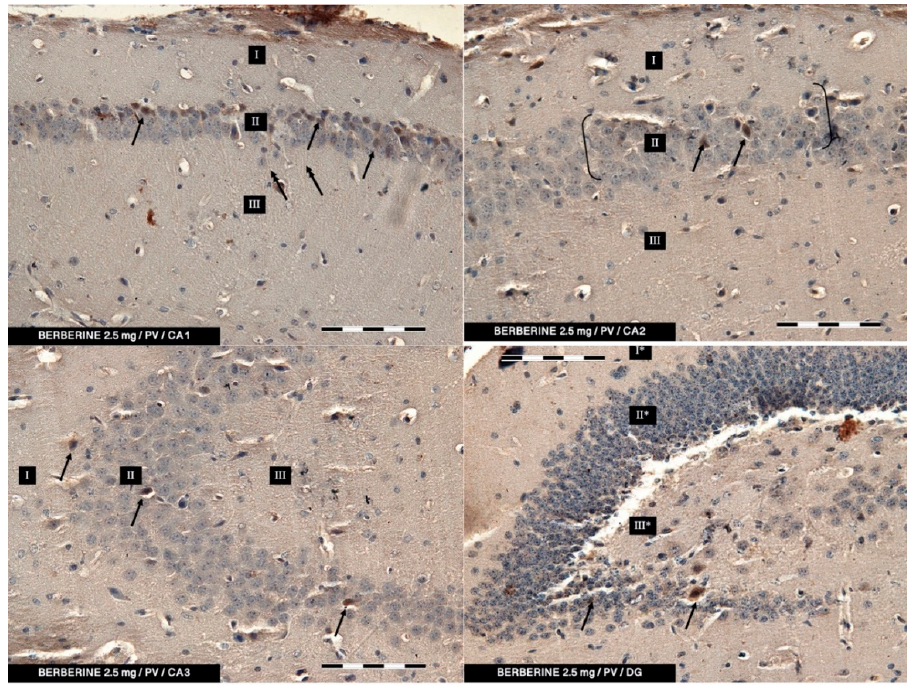
Figure 4. The experimental group treated with 2.5 mg/kg (i.p.) of BBR. The immunoreactivity of the PV-IR of moderate neurons of CA1–CA3 mouse hippocampal fields and DG of the hippocampus is observed. ( I : the marginal layer, II : the pyramidal layer, III : the multiform layer; the arrows indicate PV-IR neurons ( single arrow ) and PV-IR fibers ( double arrow ) of the hippocampus; magnification × 20).